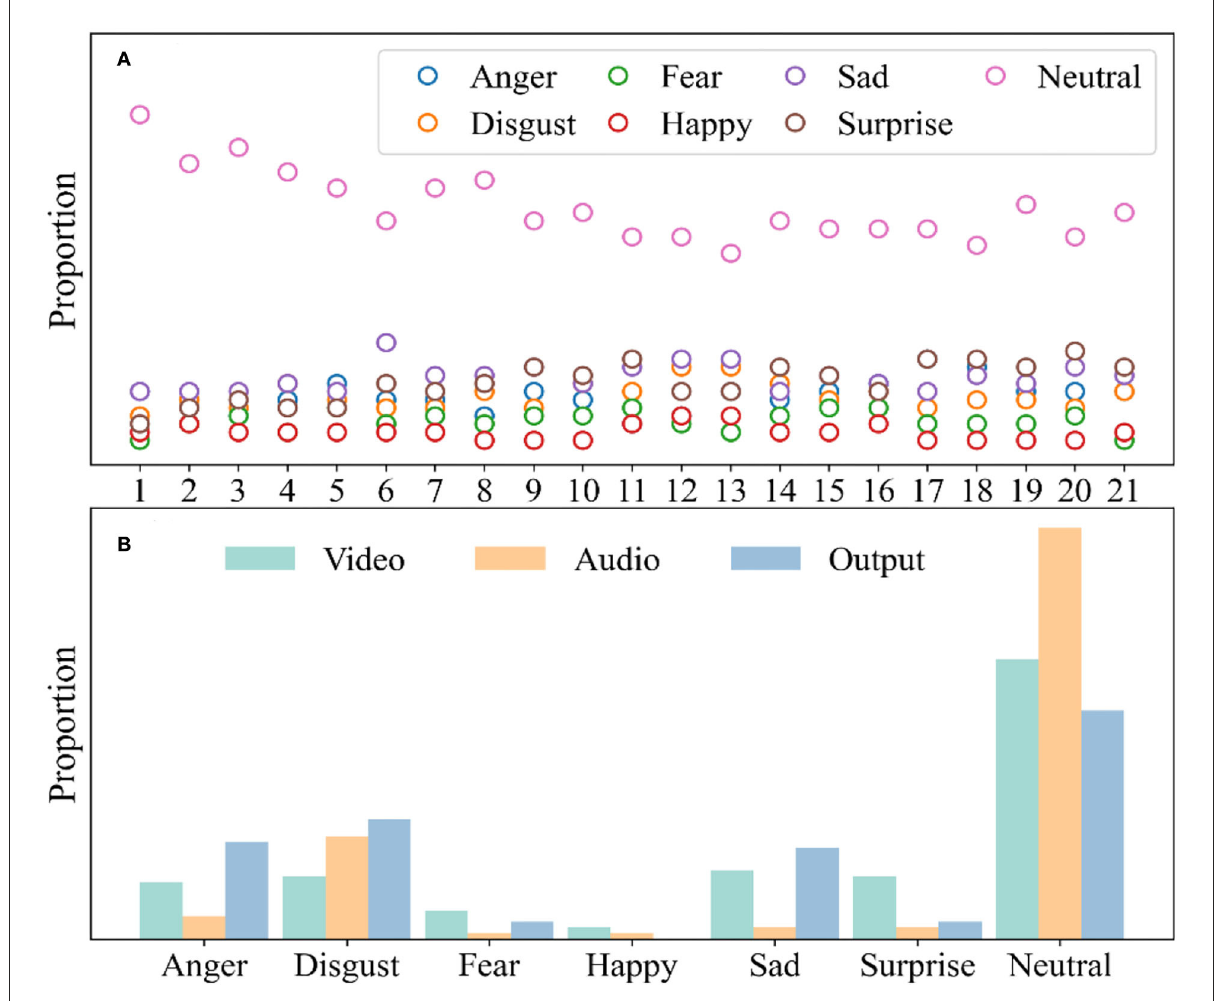
FIGURE3 Evaluation of multimodal emotional classification. (A) Time series analysis in video emotion recognition; (B) The participants’ emotion